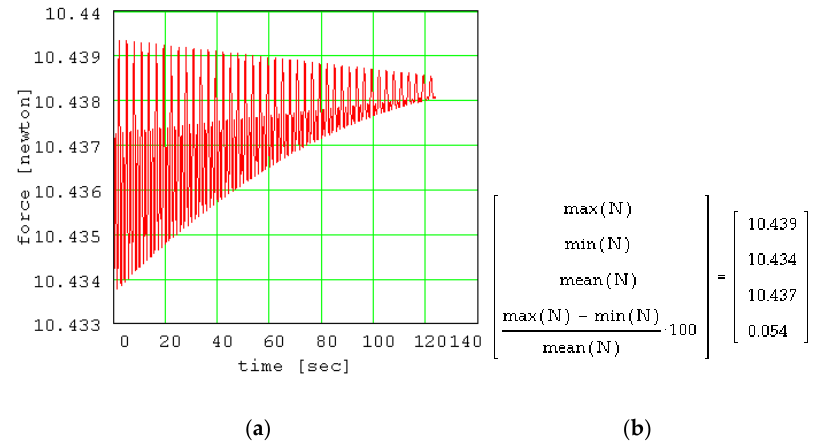
Figure 17. The variation of the normal force: ( a ) plot of normal force variation; ( b ) Mathcad results for extreme and mean values of normal force.